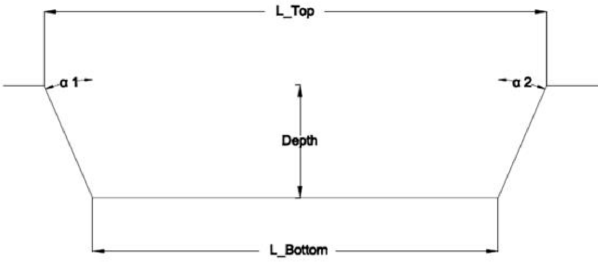
Figure 4. The five measured geometrical entities.